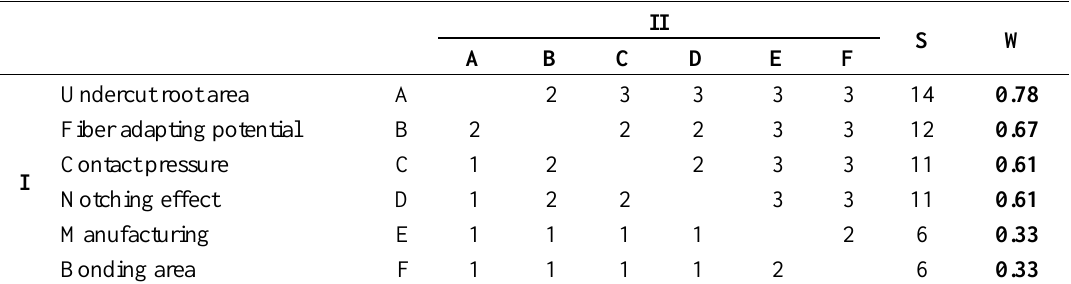
Table 1. Weighting of the different